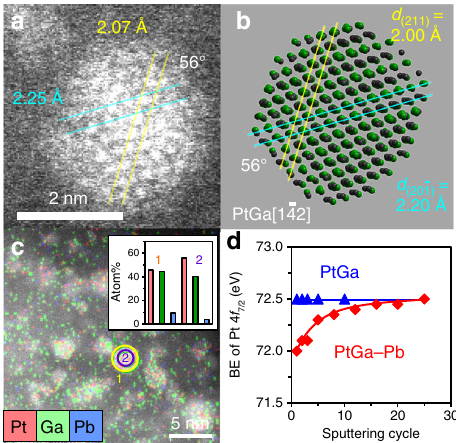
Fig. 2 Characterization of PtGa – Pb/SiO 2 . a HAADF-STEM image of a single nanoparticle in PtGa – Pb/SiO 2 (Pt/Pb = 2). b Crystal structure of intermetallic PtGa viewed along [1 (cid:1) 42] direction. c Elemental map of Pt, Ga, and Pb acquired by EDX. Inset shows their atom% included in areas 1 (yellow circle) and 2 (purple circle), corresponding to the whole and core region of a single nanoparticle. d Changes in Pt 4 f 7/2 -binding energy (BE) of PtGa/SiO 2 and PtGa – Pb/SiO 2 (Pt/Pb = 2) during sputtering